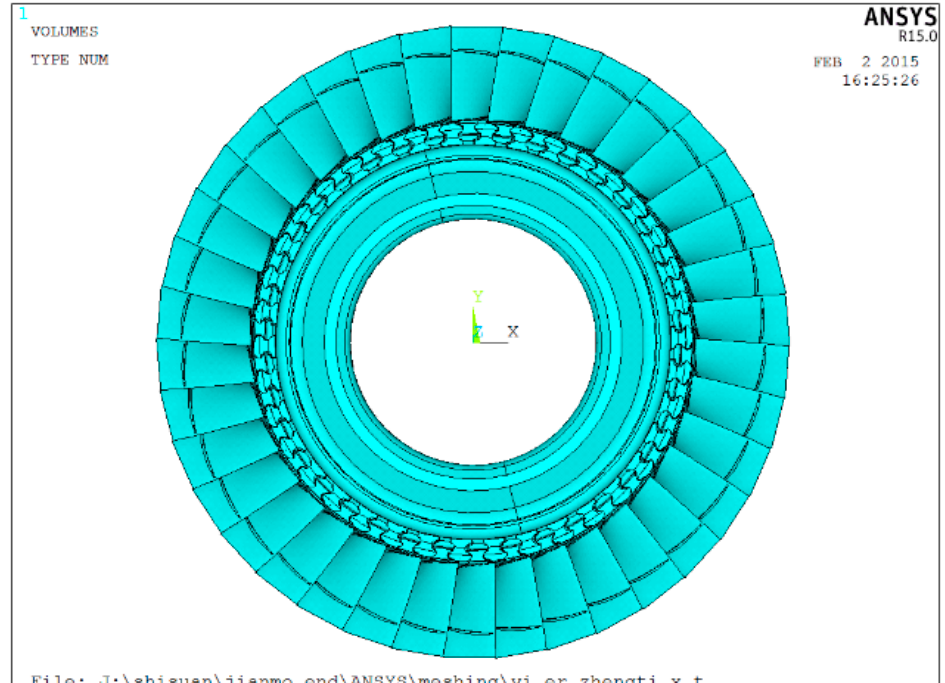
Figure 8. Three-dimensional solid model of the first-stage leaf disk.